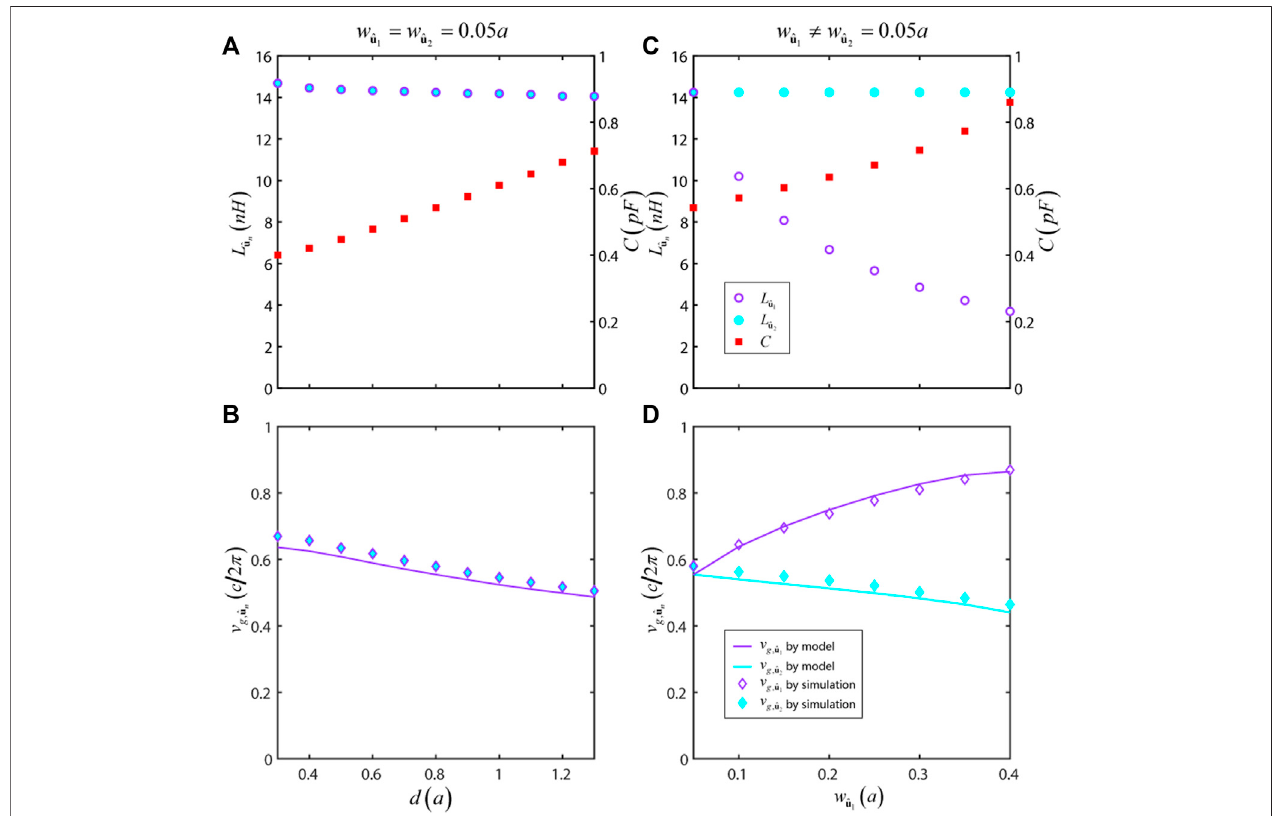
FIGURE 4 | Tuning the group velocities of index ellipsoids by the inductances L ^ u inductances and capacitance for the isotropic MM. Here, we change the metallic block ’ s height while keeping the other parameters unchanged (width w p = 0.4 a and (cid:2) w ^ (cid:2) 0 . 05 a ). (B) Group velocities of the index circle at quasistatic limit as a function of d . Solid lines are given by the equivalent circuit model, while symbols are w ^ u u 2 1 givenbythesimulatedbandstructure. (C,D) ThesameaspanelsAandBbut fortheanisotropicMM, wherewechangeoneofthebar widths w ^